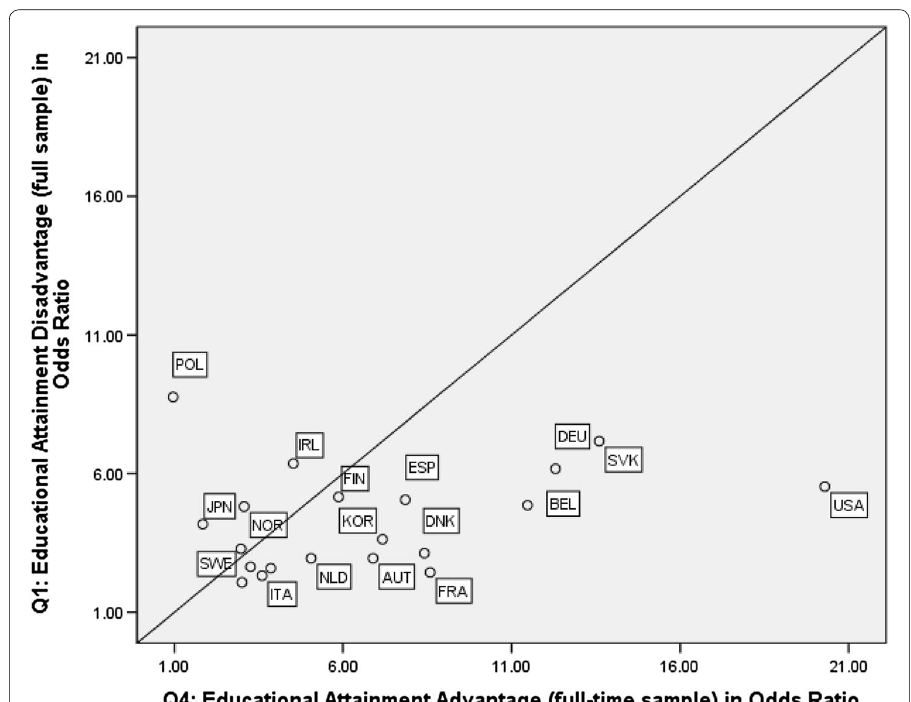
Fig. 6 Q1, Model 3: Lowest Educational Attainment Disadvantage vs. Q4, Model 3: Highest Educational Attainment